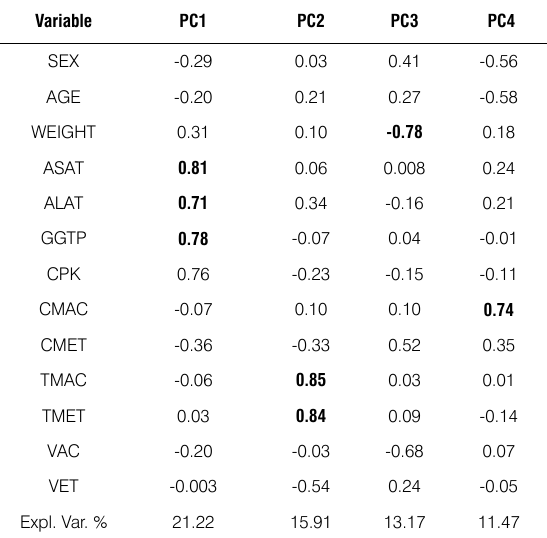
Table 3. Factor loadings for 5